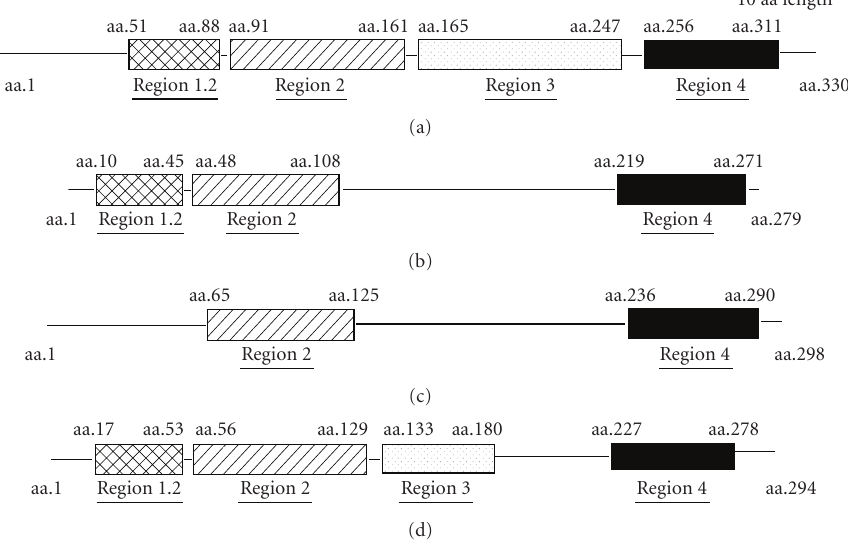
Figure 2: Comparison of the conservative domains among rpoS , rpoX, and the other rpoS -like sigma factors. (a) Conserved rpoS domains in V. alginolyticus, (b) rpoX conserved domains in V. alginolyticus 12G01 and ZJ-51, (c) conserved domains in rpoS -like sigma factors in Vibrio sp. MED222 and V. splendidus LGP32, and (d) RpoQ conserved domains in V. fischeri ES114. Compared with rpoS and RpoQ, rpoX does not have the sigma 70 region 3, but it contains sigma 70 region 1.2, a region that is absent in the rpoS -like sigma factors of Vibrio sp. MED222 and V. splendidus LGP32.